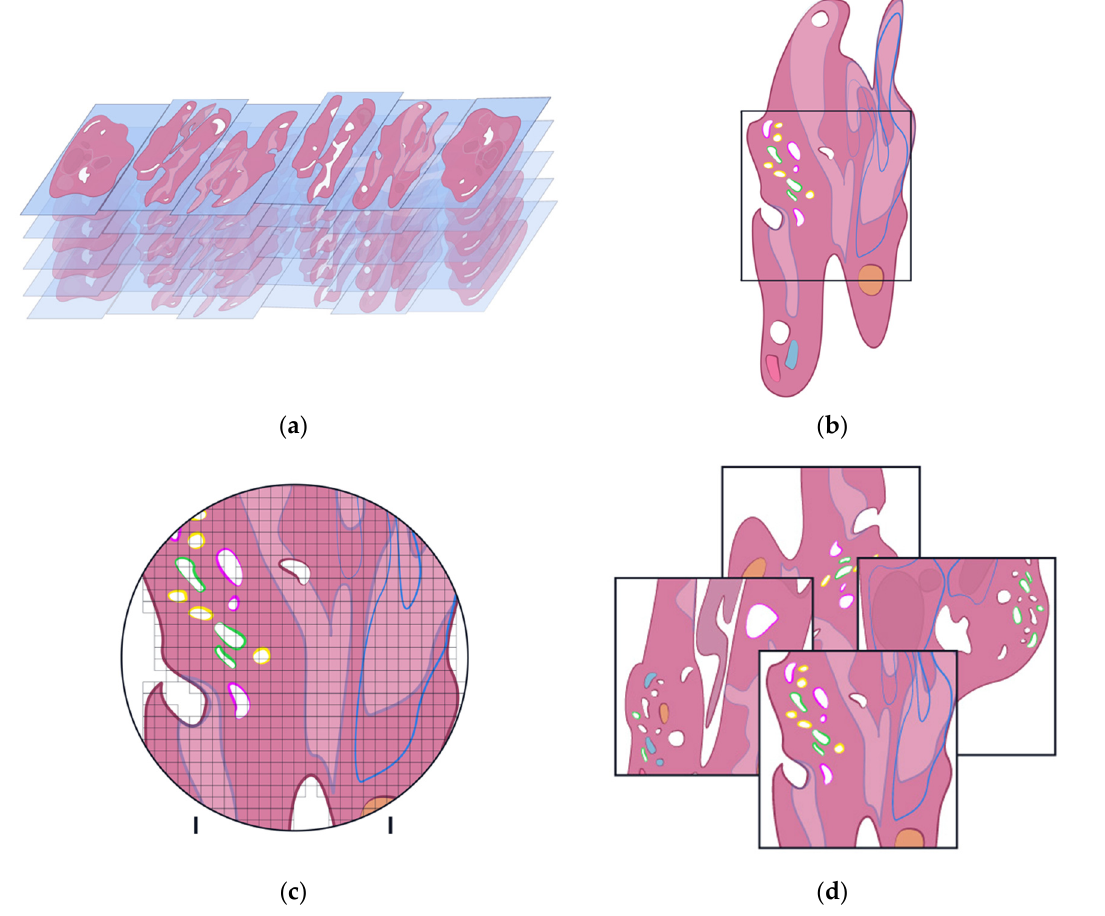
Figure 6. WSI patch extraction for algorithm training (original figures). ( a ) WSI dataset; ( b ) WSI region of interest for patch selection; ( c ) patch selection; ( d ) extracted patches used for algorithm training. Demarcated and colored areas on pink WSI specimen represent computer-assisted pathologist annotations.